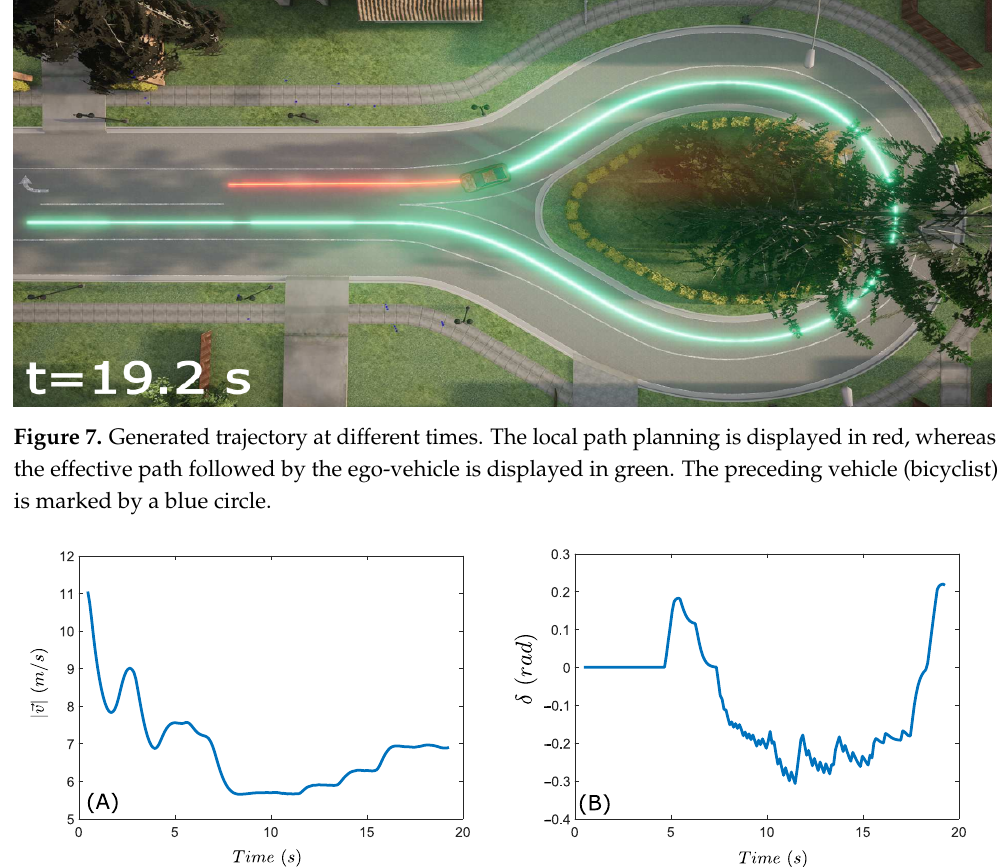
Figure 8. ( A ) Velocity profile generated along the path. ( B ) Steering angle calculated by attractor across the reference